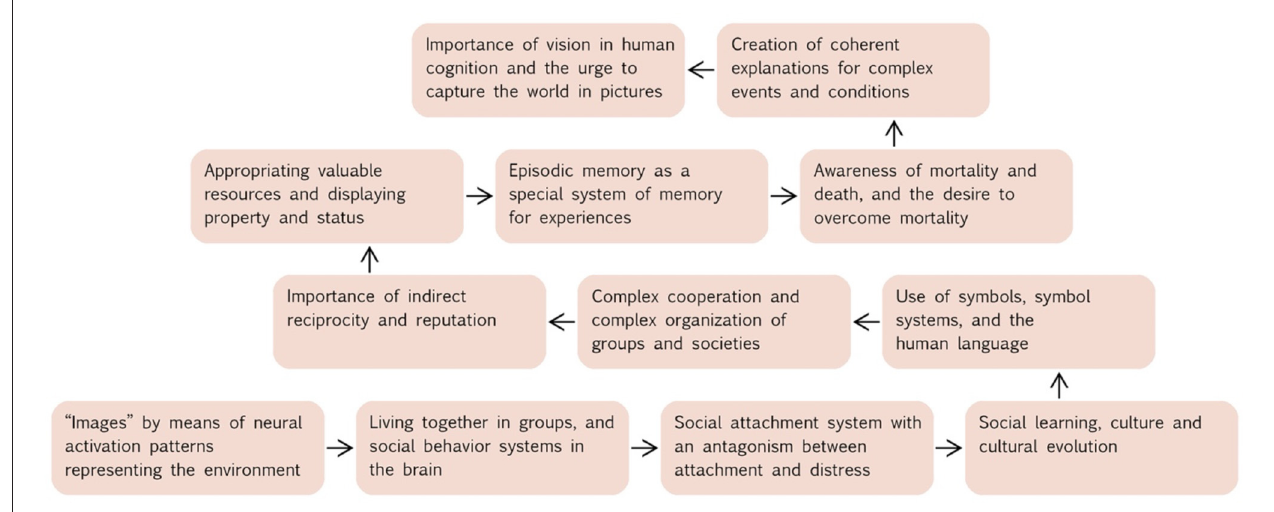
FIGURE 2 | Schematic illustration of the building blocks that are part of the evolved nature of modern humans and form the basis of the importance of photos for people. The arrows show the order in which we describe the building blocks in our